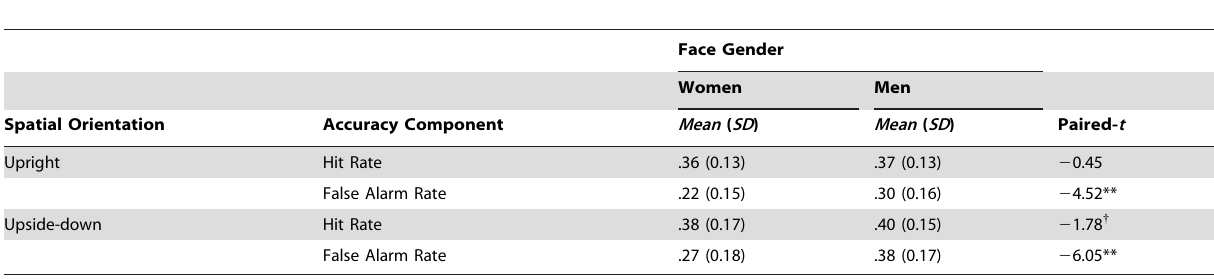
Table 1 Note: Upright n =67; upside-down n =62. Hit rates are the proportion of gay faces correctly identified as gay; false alarm rates are the proportion of straight faces incorrectly identified as gay. { p , .10. ** p ,